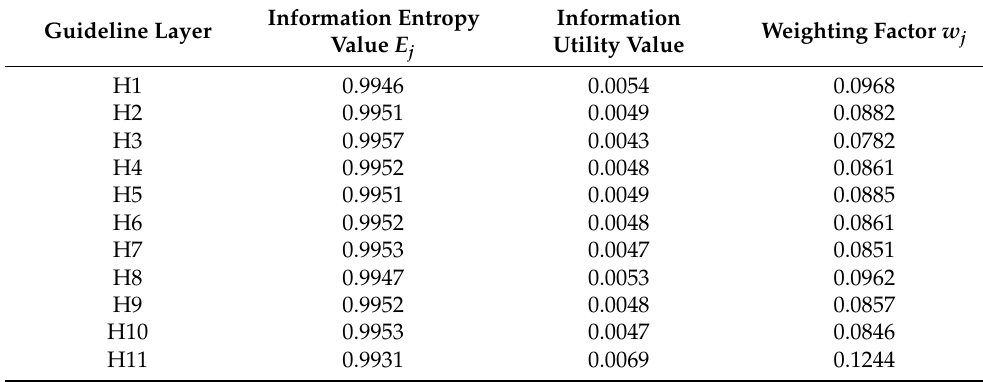
Table 13. Weight results of each index based on entropy method.